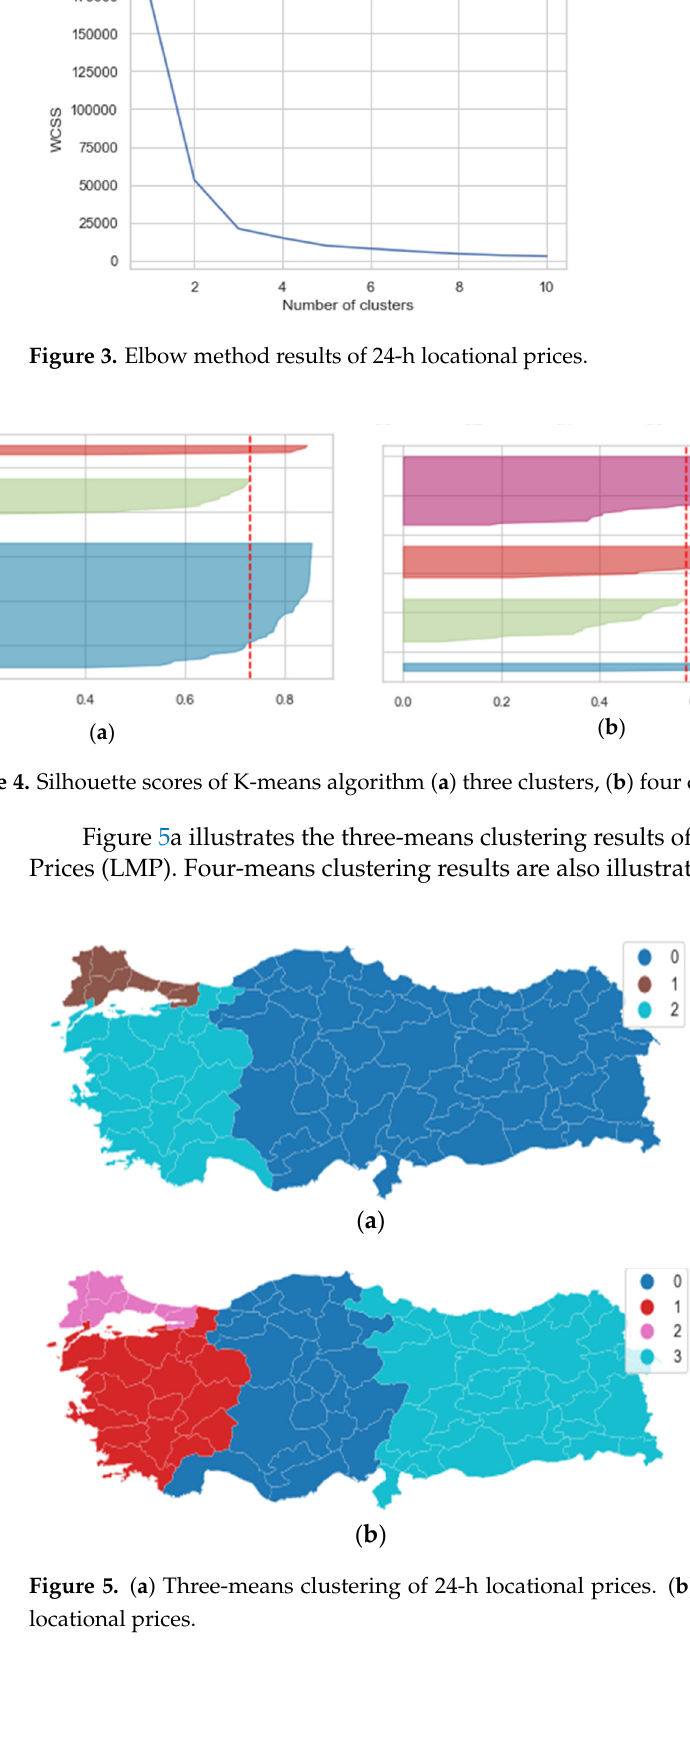
Table 1. Statistical measures of k-means clustering. Method